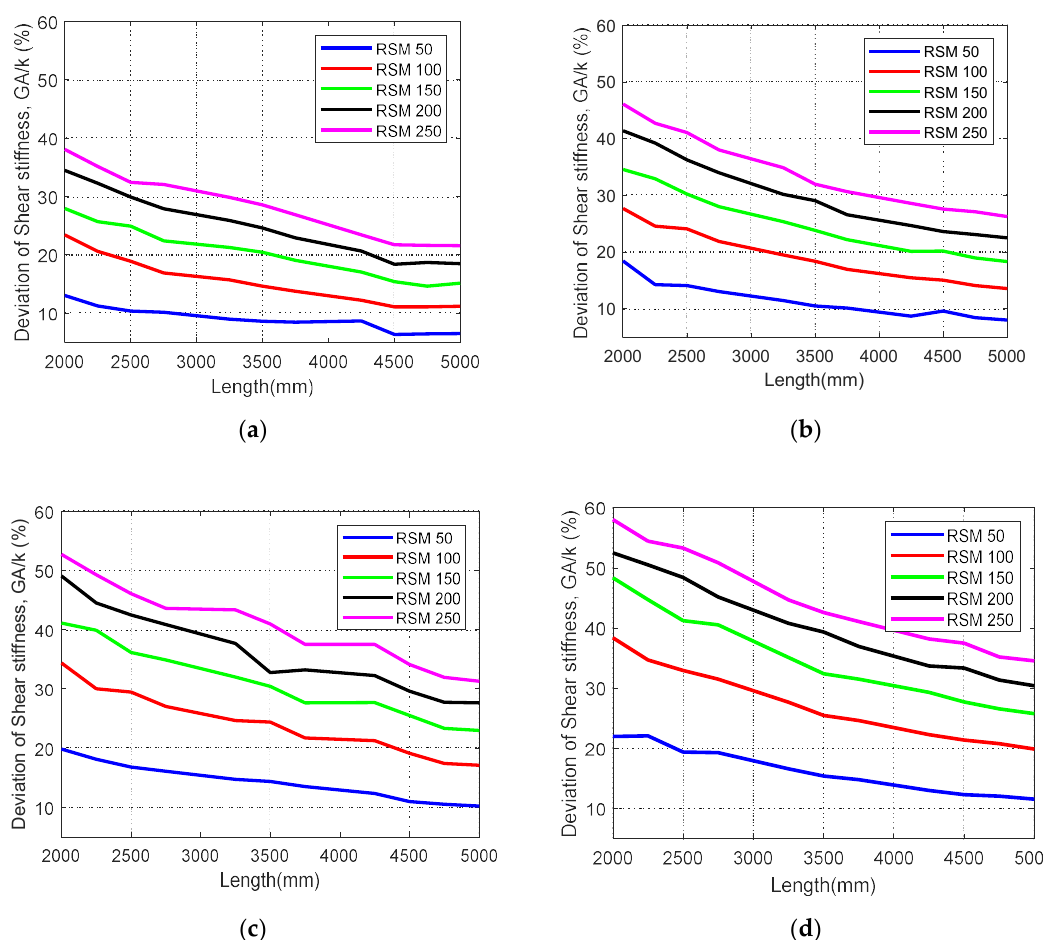
Figure 8. Deviations of analytical vs. FE shear stiffness for the considered CLT panels: ( a ) 90 mm thick CLT panels, ( b ) 120 mm thick CLT panels, ( c ) 150 mm thick CLT panels and ( d ) 180 mm thick CLT panels.